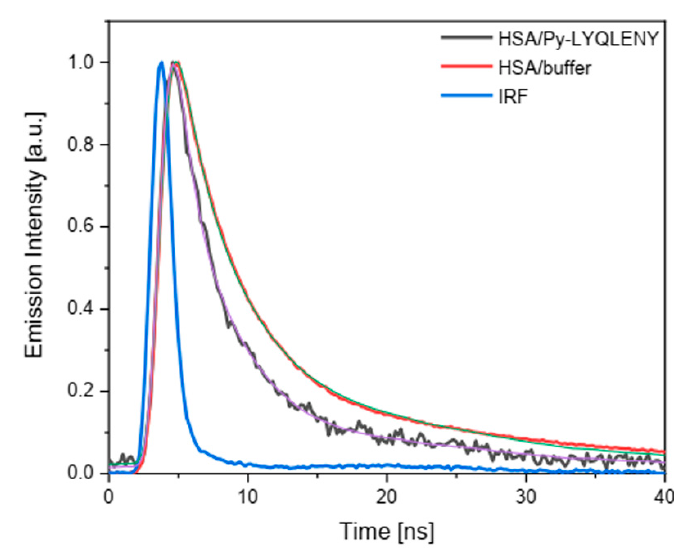
Figure 8. Decay curves of excited Trp214 in the presence of Py-LYQLENY; [HSA] = 30 µM, λ exc = 295 nm, λ em = 340 nm. Smooth lines: bi-exponential fits to experimental runs.